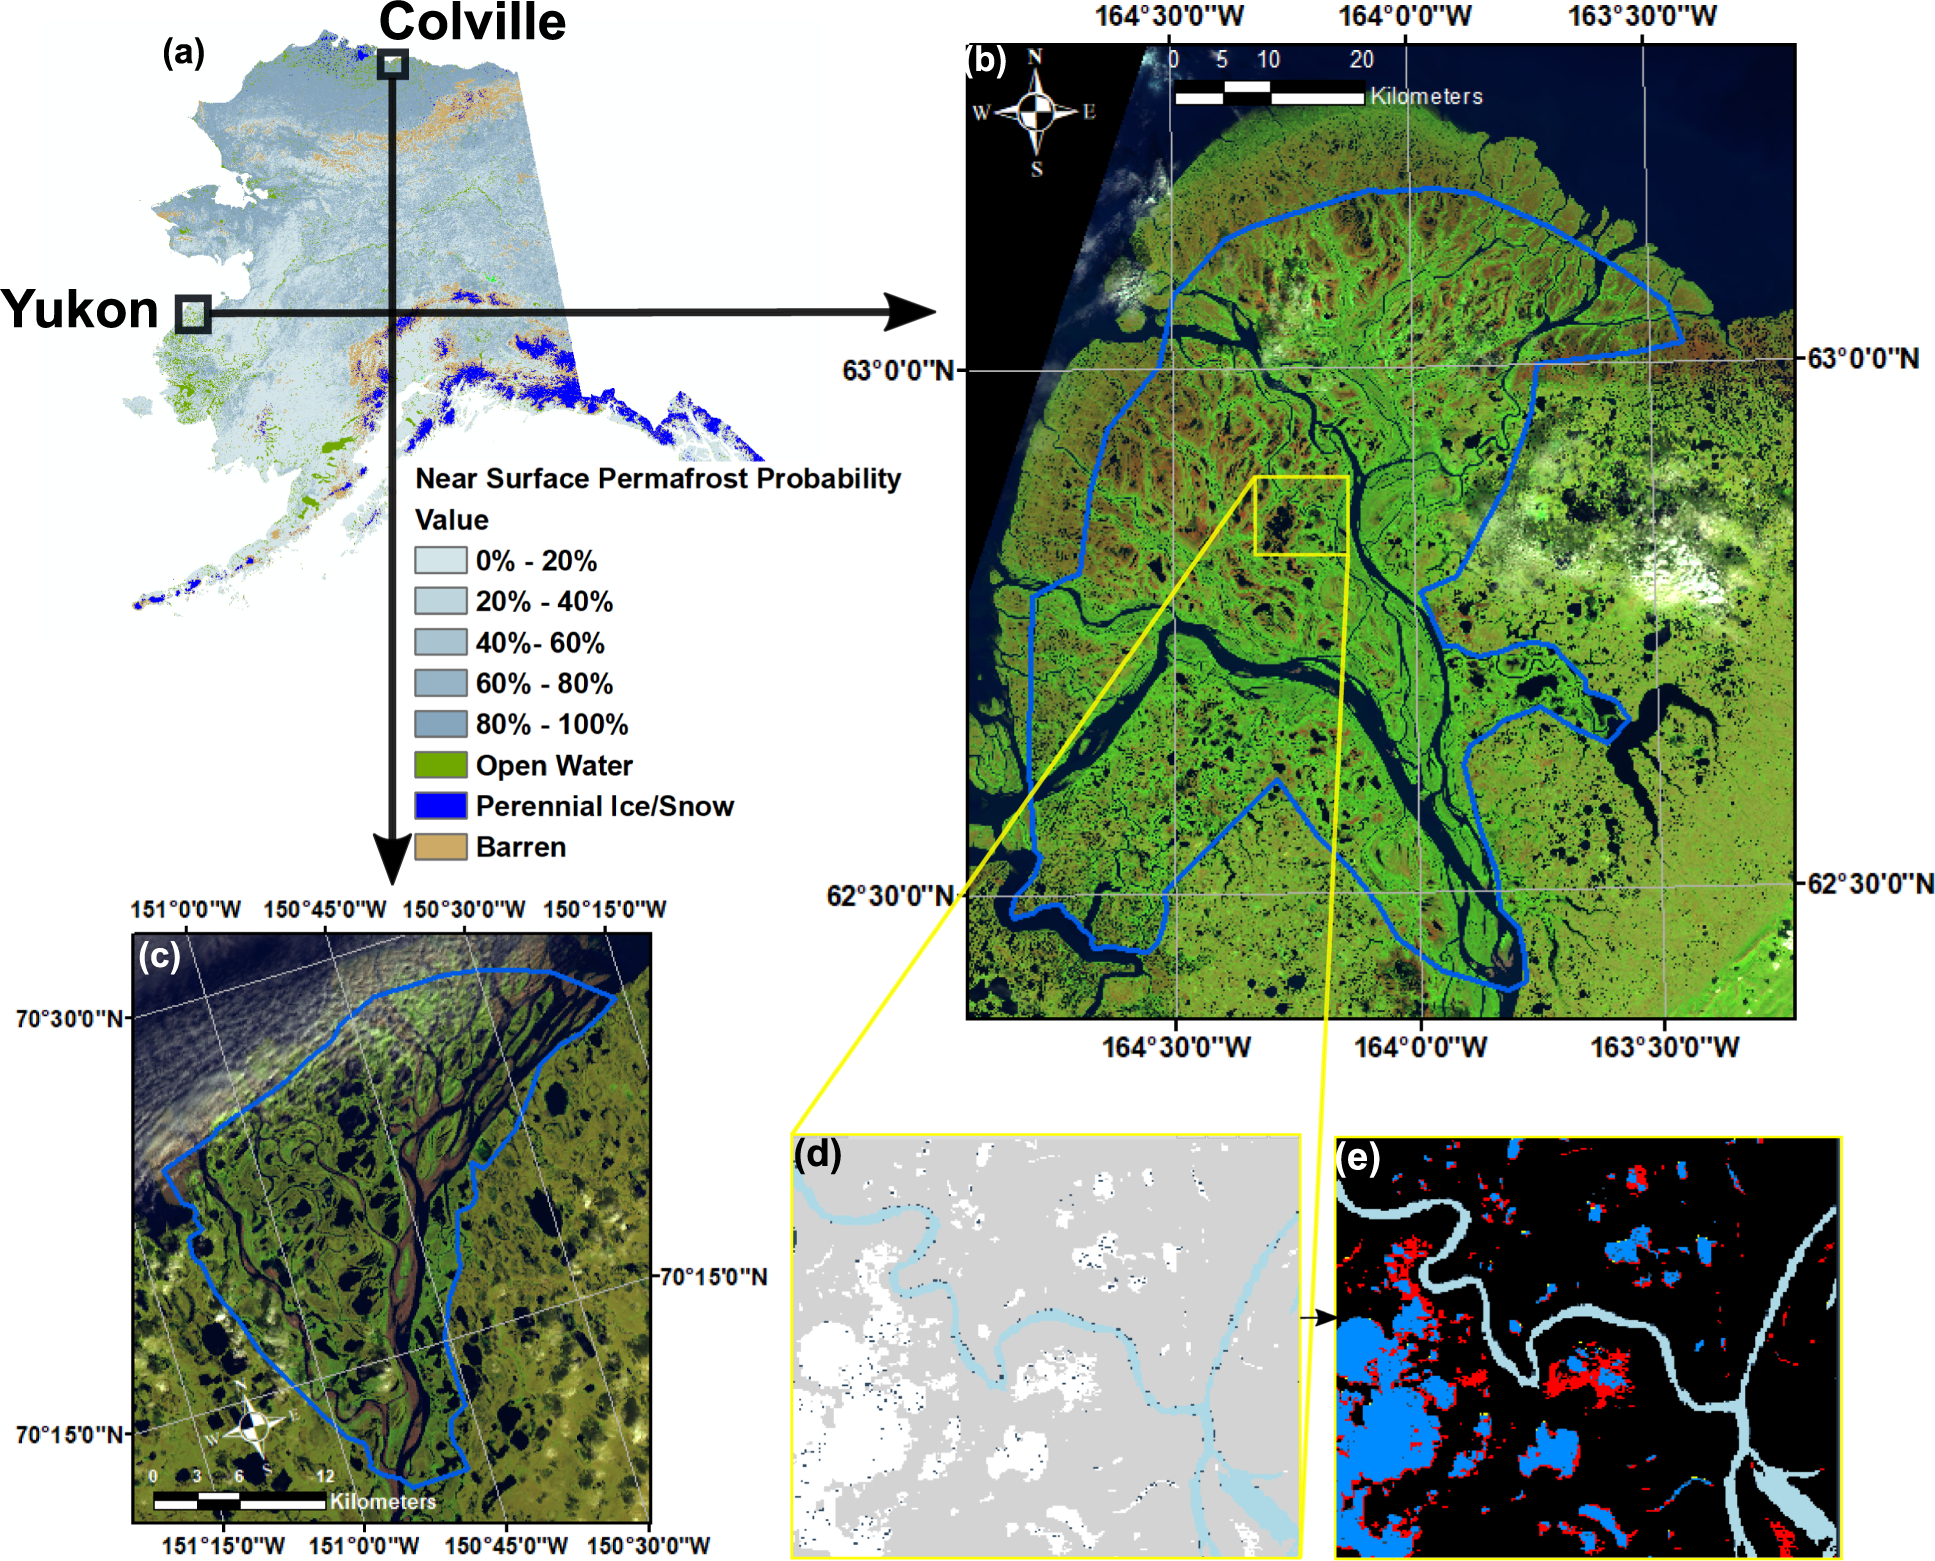
Study areas and illustration of seasonal lake area shrinkage. (a) A map of the near-surface permafrost probability from Pastick et al. (2015) and the locations of the Colville and Yukon deltas. (b) A Landsat 8 scene (falsely colored in R-Surface Water Infrared, G-Near Infrared, B-Green) taken on 6 July 2014 over the Yukon Delta, with the study zone outlined in blue. (c) The same over the Colville Delta on 12 August 2014. (d) The classified June 2008 water mask from the Global Surface Water (GSW) data set, with land in gray, channels in light blue, lakes in white, and no data in dark gray. (e) The lake area shrinkage from June to July 2008 is depicted with water that drained or evaporated marked in red, water that remained water in dark blue, and land shown in black.